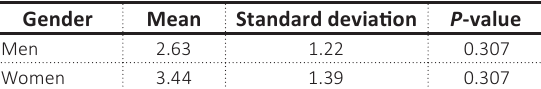
Table 9. Job satisfaction and relationship